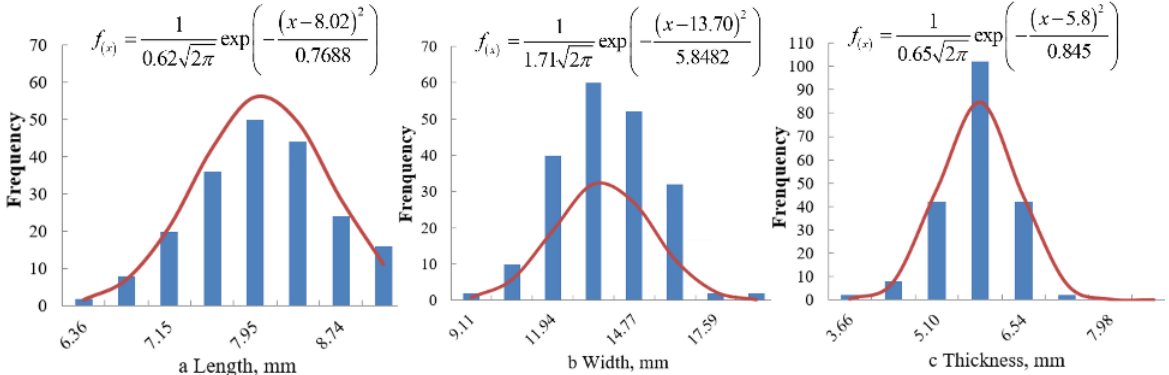
Figure 3. Distribution of the size of Jinong 2 seeds: ( a ) length; ( b ) width; and ( c ) thickness.